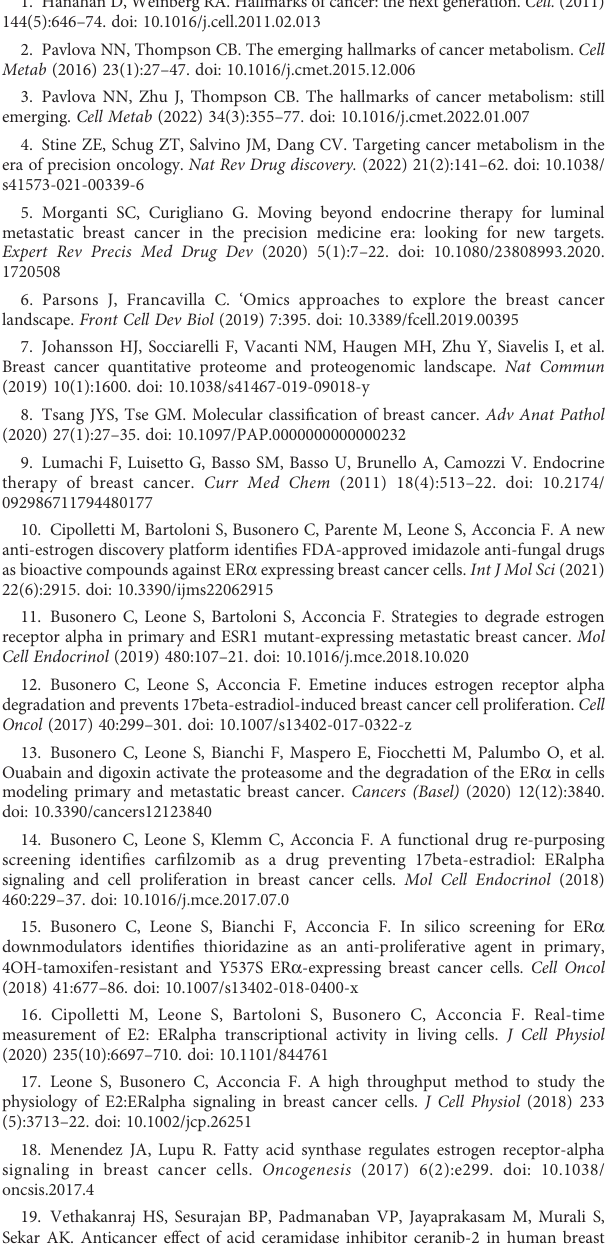
SUPPLEMENTARY FIGURE 4 Histograms relative to fi gure 5C and 6C. Densitometric analyses for fi gure 5C (A and B) and for fi gure 6C (C) . The experiments were performed 4 times. Signi fi cant differences were calculated with Anova test. **** (p value <